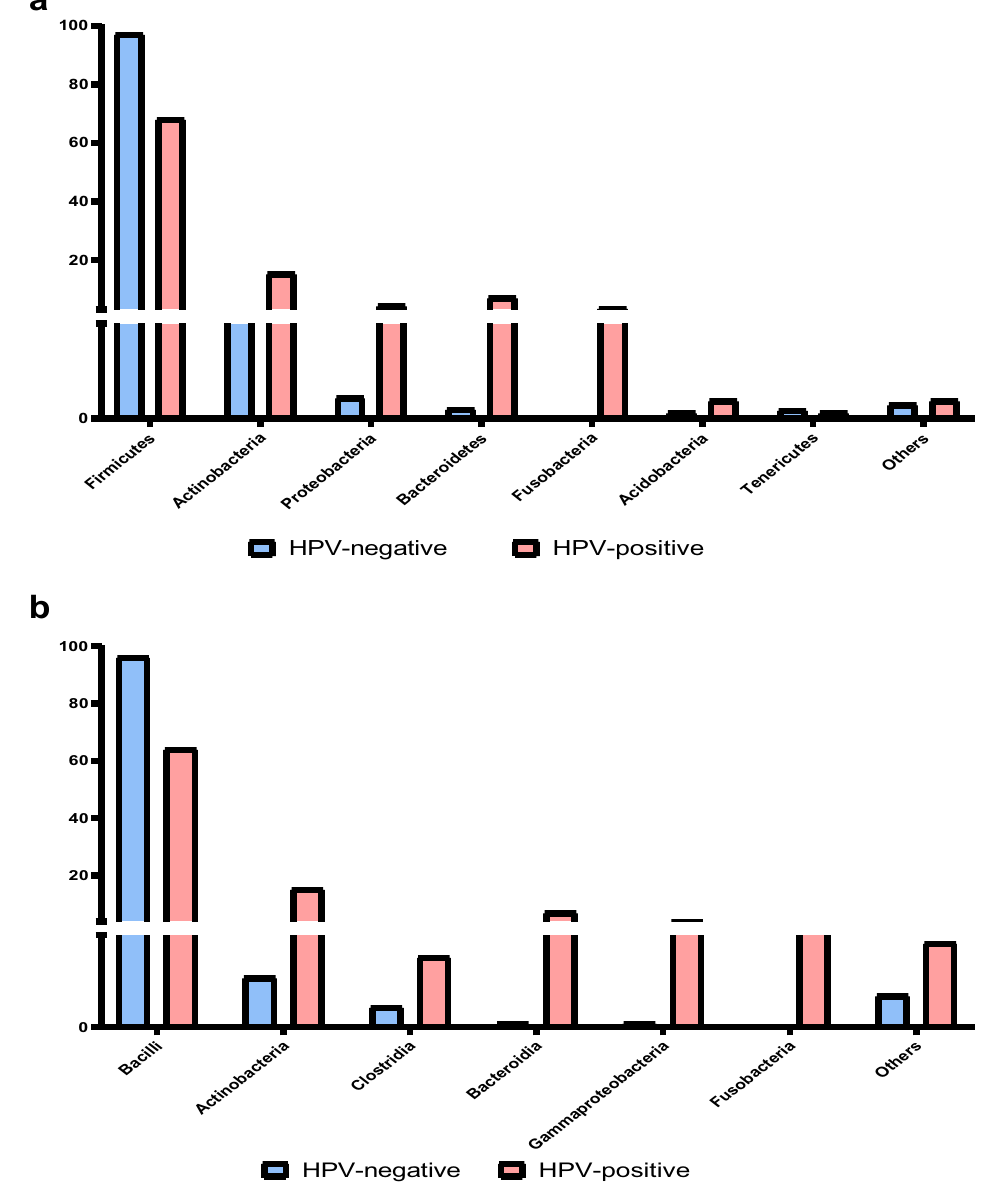
Figure 2. Vaginal microbiota distribution in HPV infectious women. ( a ) Vaginal microbiota in the phylum level of the HPV-negative group and the HPV-positive group. ( b ) Vaginal microbiota in the class level of the HPV-negative group and the HPV-positive group. ( c ) Vaginal microbiota in the order level of the HPV-negative group and the HPV-positive group. ( d ) Vaginal microbiota in the genus level of the HPV-negative group and the HPV-positive